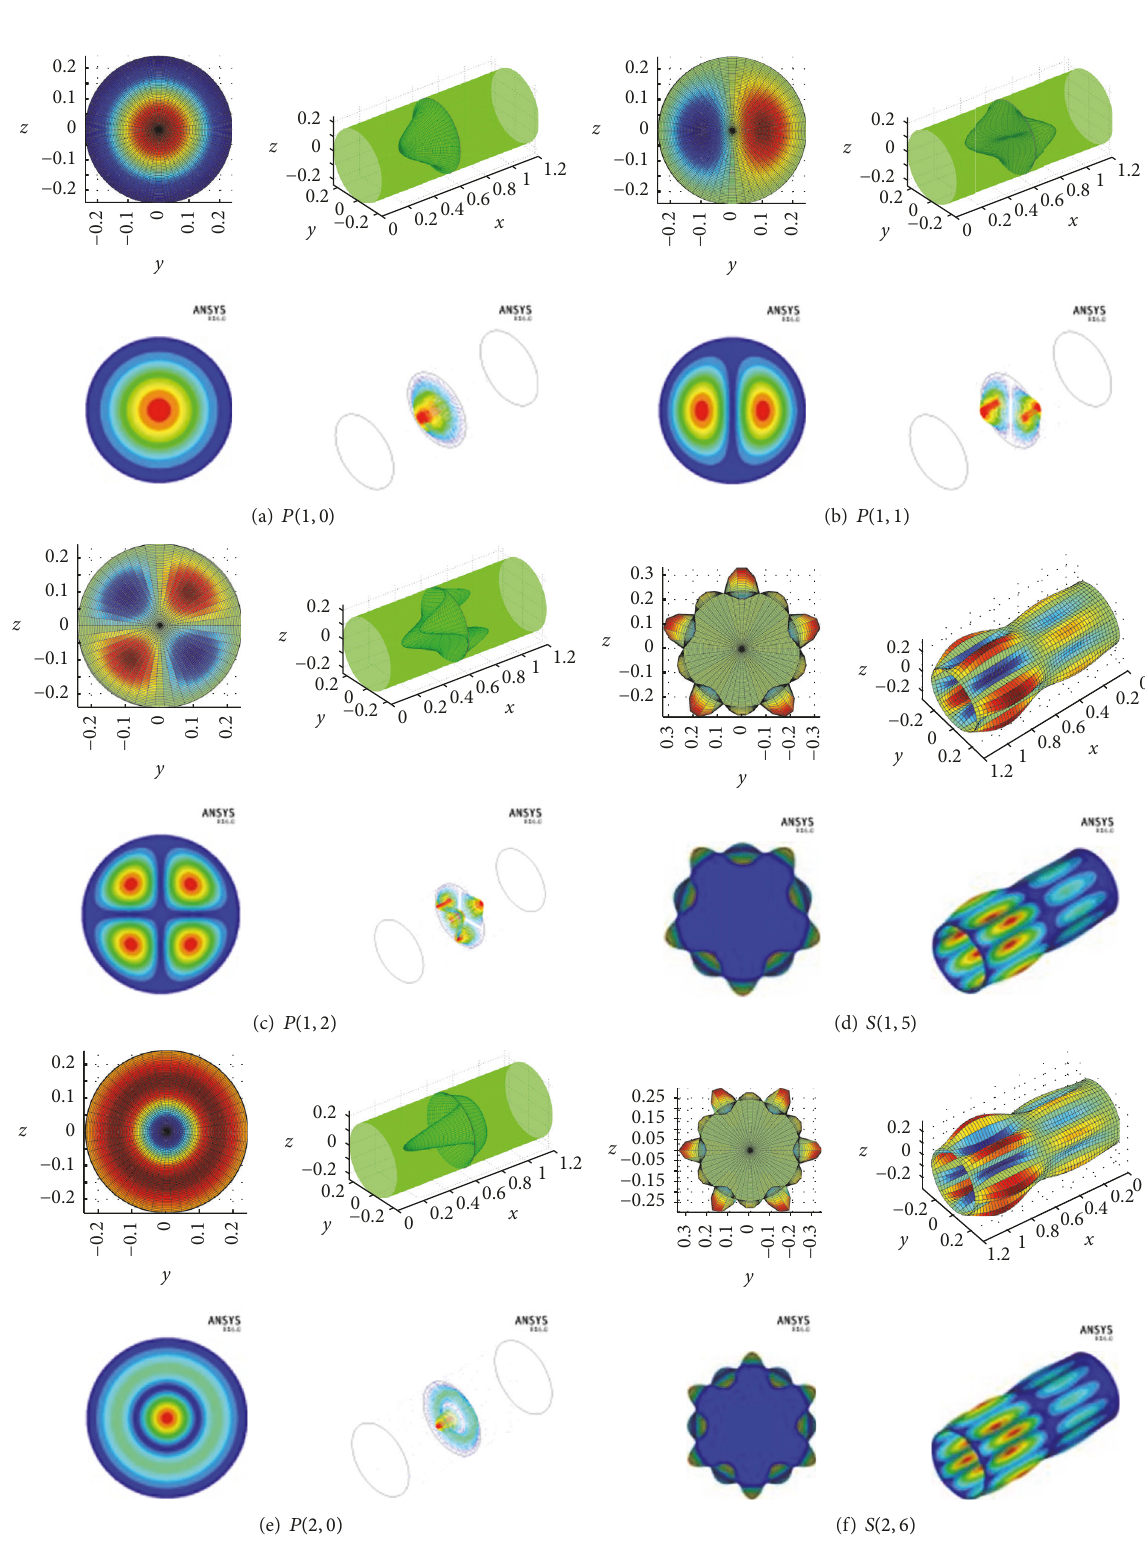
Figure 7: The modes of coupled structures with